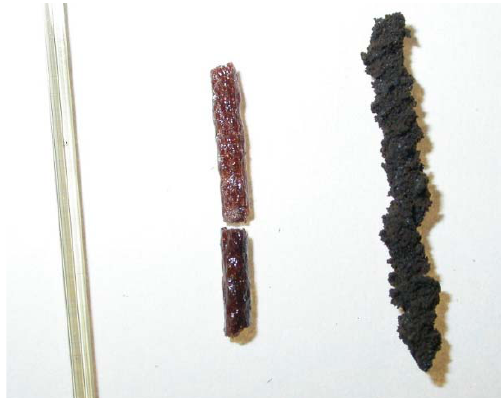
Figure 3. Photographs from left to right of: extruded commercial PSF (Udel P3500) at 300 °C, SPSFH (IEC = 1.35 H + /kg) form at 210 °C, SPSFNa (IEC = 1.3 Na + /kg) form at 320